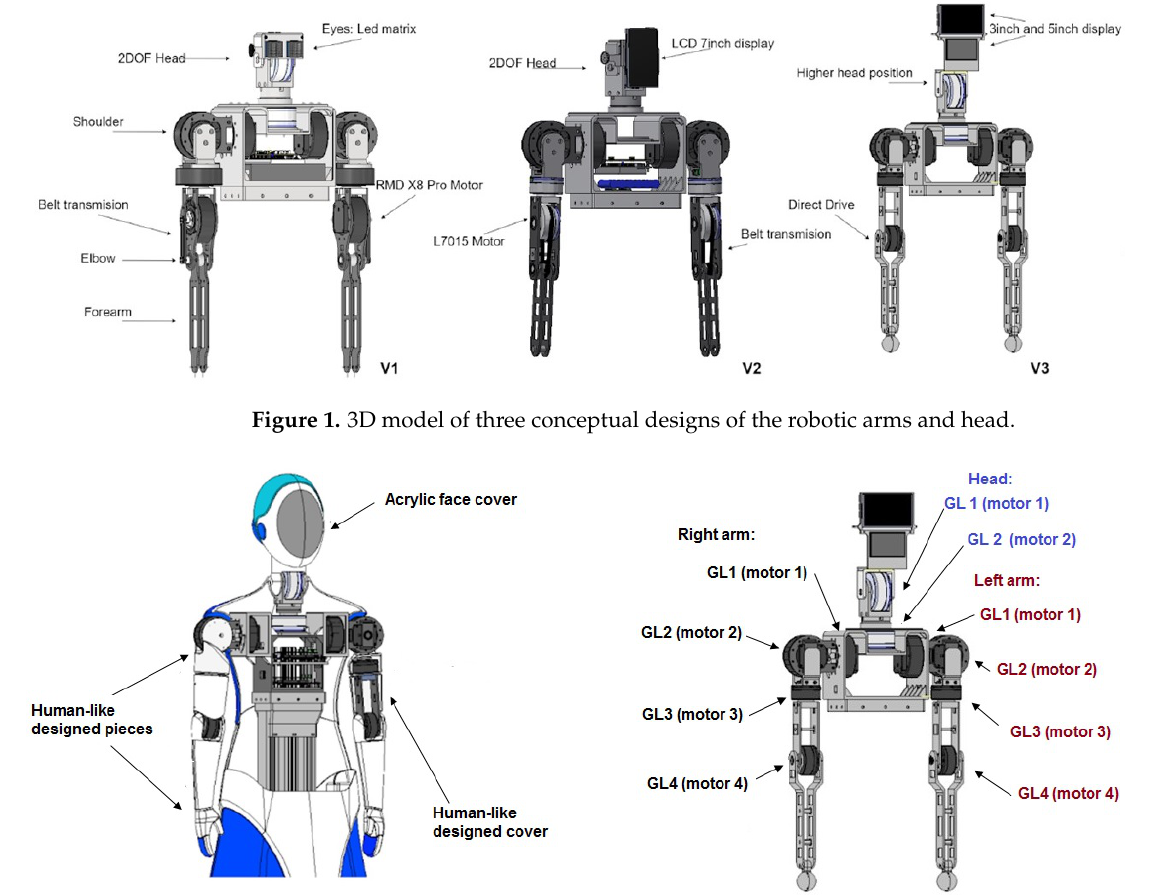
Figure 2. Visual representation of the design of humanoid and notation of each degree of